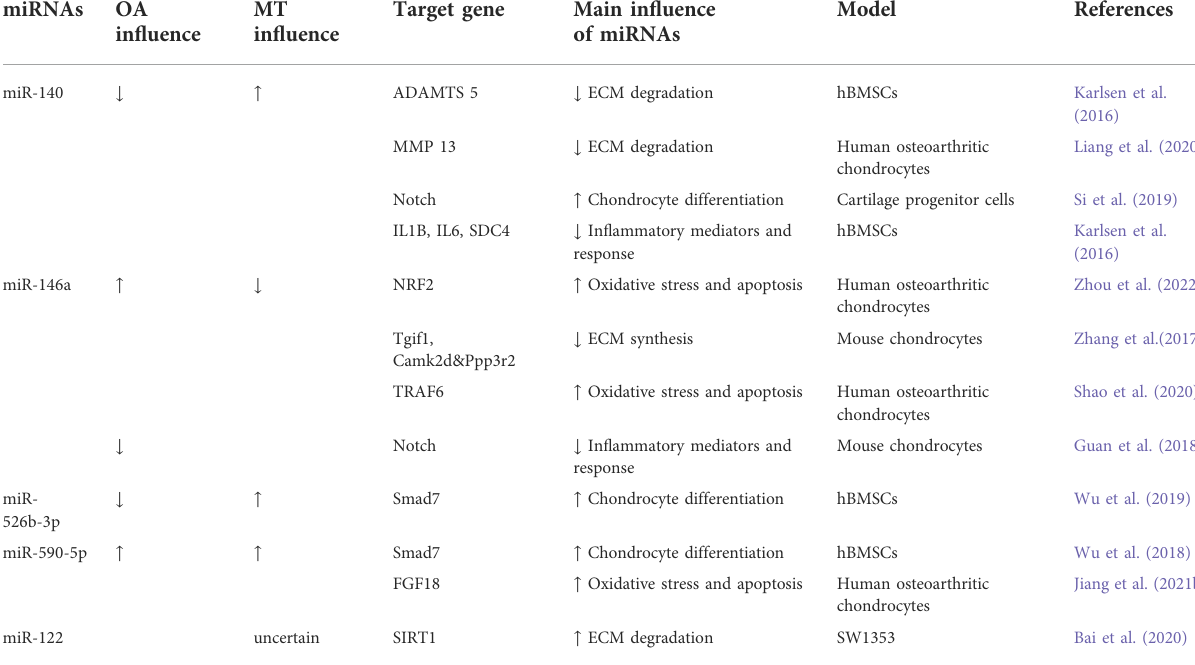
TABLE 1 Summary of differentially expressed miRNAs concerning the regulatory effect of melatonin on OA discussed in this review.